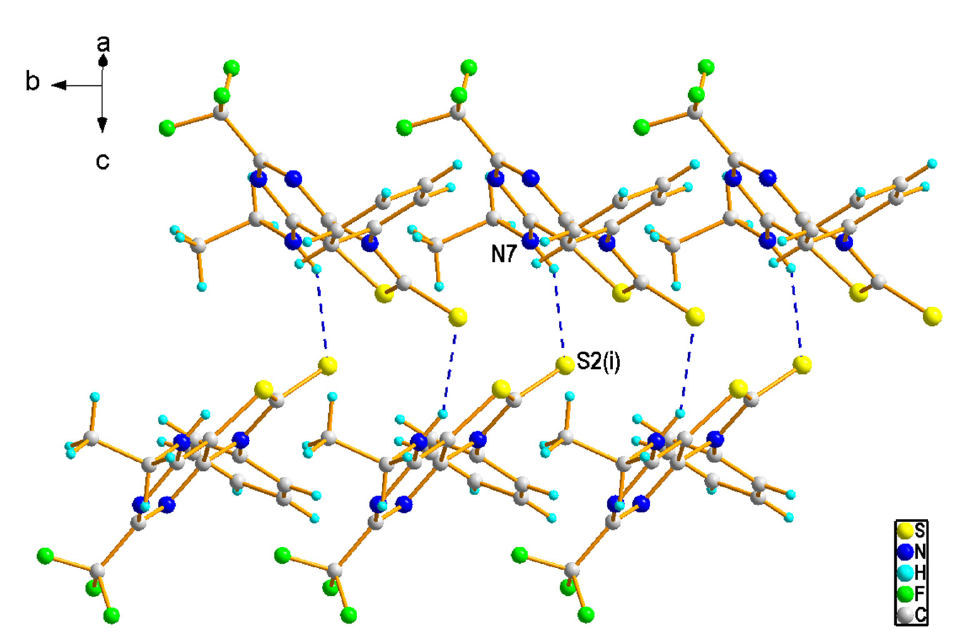
Figure 5. A part of crystal packing of 4b showing a zig-zag chain formed by N-H ··· S interactions (depicted as blue dashed lines).